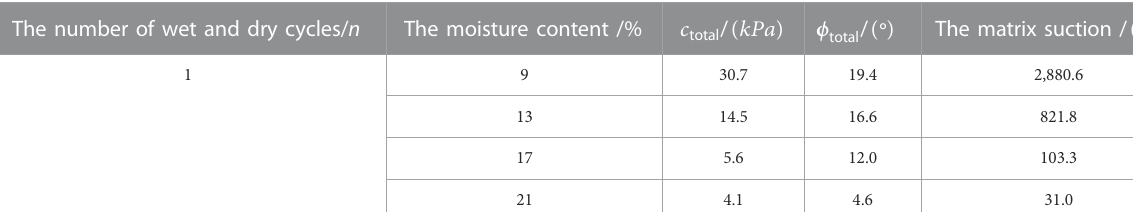
TABLE 3 The total stress shear strength indices and the matric suction of the samples under the different DWC. The number of wet and dry cycles/ n